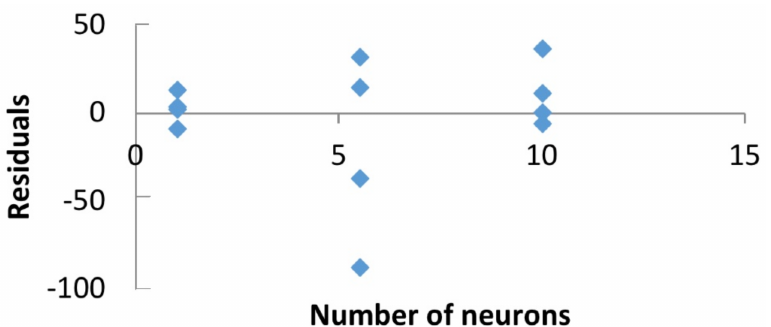
Figure 3. Residuals for the C